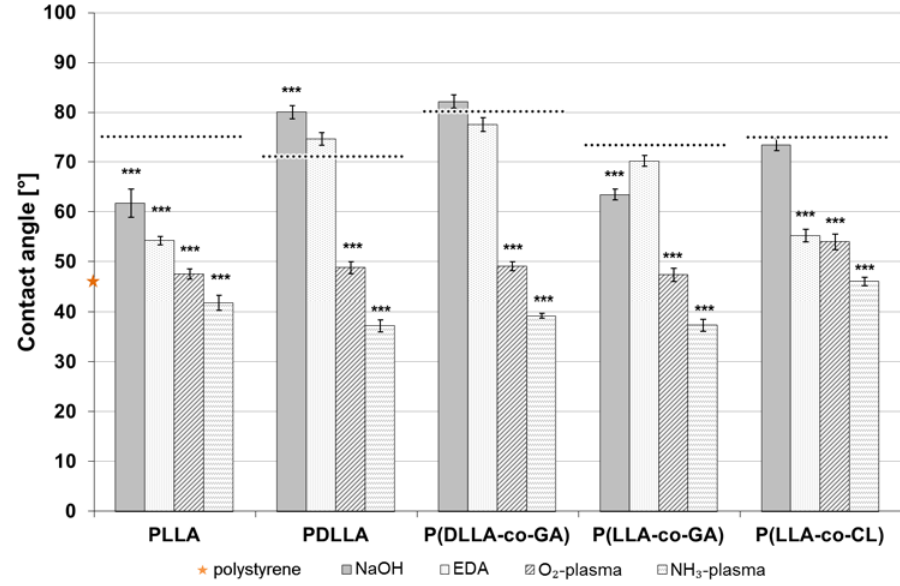
Fig 2. Contact angle measurements. Mean values of contact angle measurements of water by sessile drop method on unmodified and modified polymer surfaces (n = 10) ± SEM. Dotted lines indicate the contact angle of unmodified polymers. (p * (cid:3) 0.05, p ** (cid:3) 0.01, p *** (cid:3)